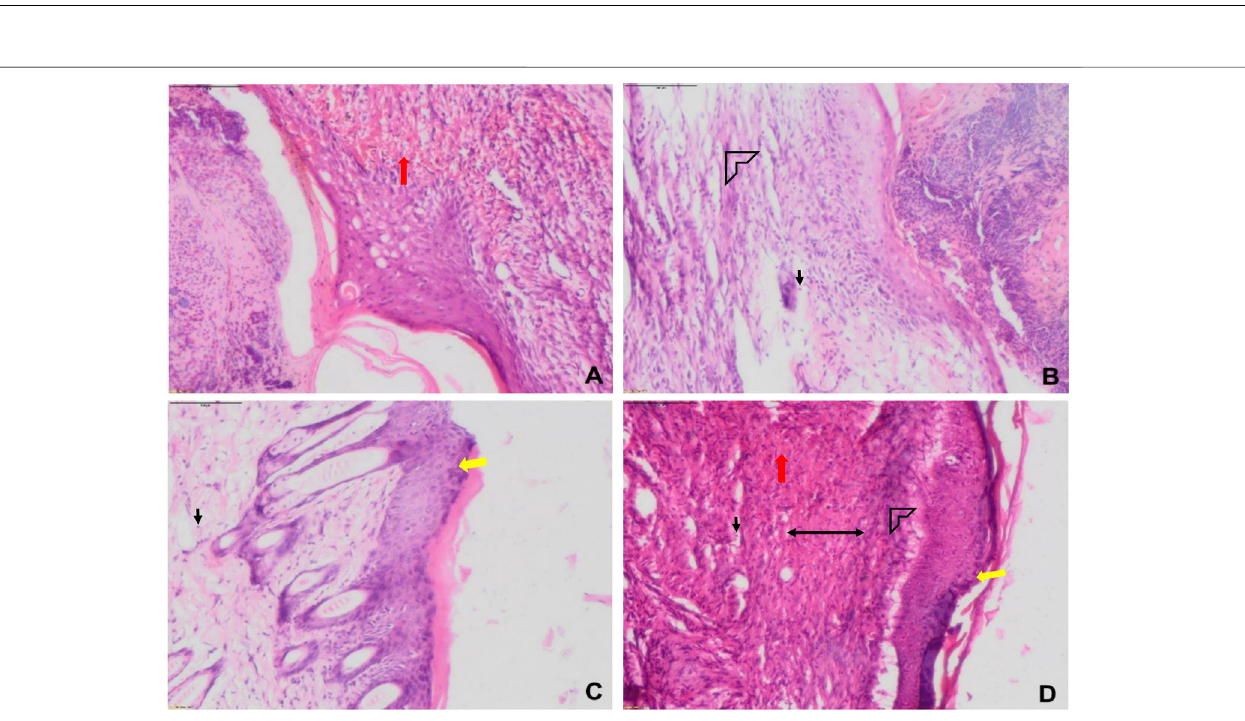
FIGURE9| Representativehistologicalimagesofwoundsofvariousgroupsonday1 (A) andday7 (B – D) . (A) sham, (B) vehicle(CMC), (C) positive(betadine), (D) Lp2621 (scale bar (cid:1) 100 μ m). Fibroblasts (black), vascularization (red), re-epithelization (yellow), collagen deposition (arrow head), and granulation of tissue (double-sided arrow).